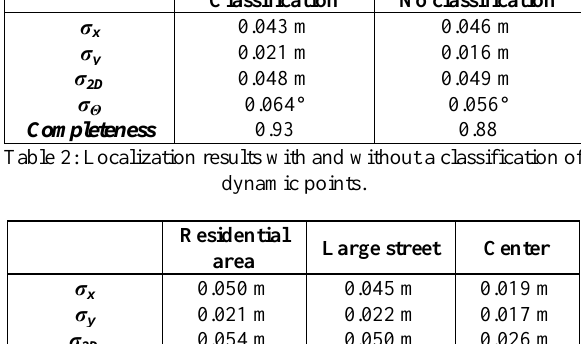
Figure 11: Localization results in a residential area with narrow streets and buildings standing close in Hannover,